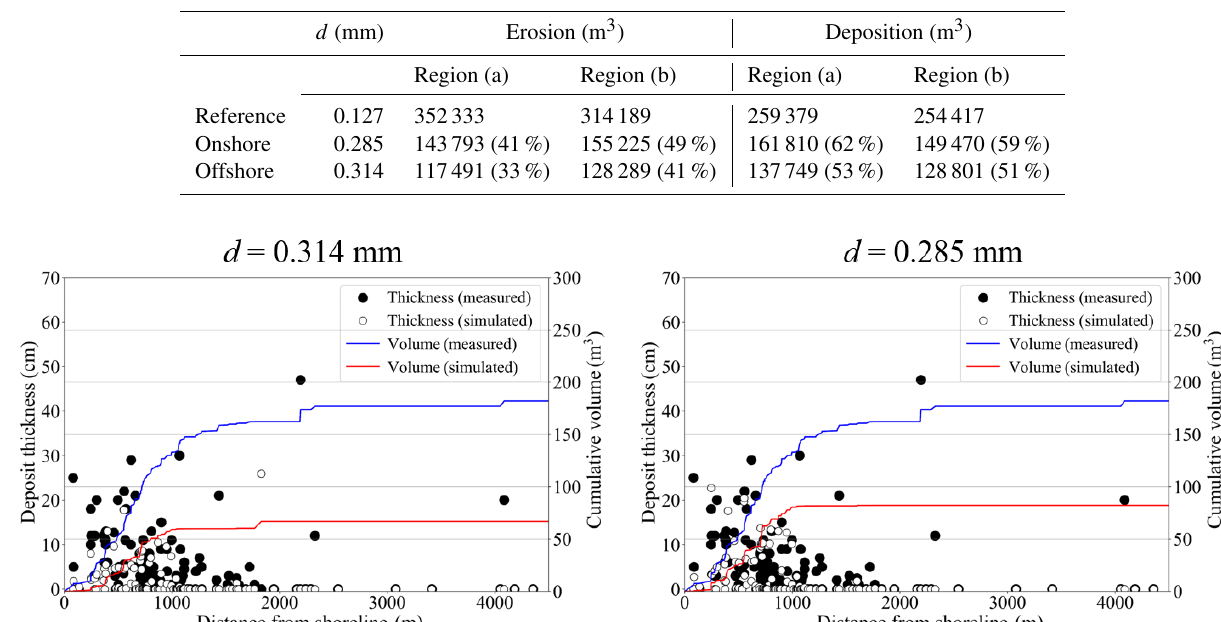
Table 3. Volume of erosion and deposition in regions (a) and (b) for each grain size (percentage shows the ratio to reference).